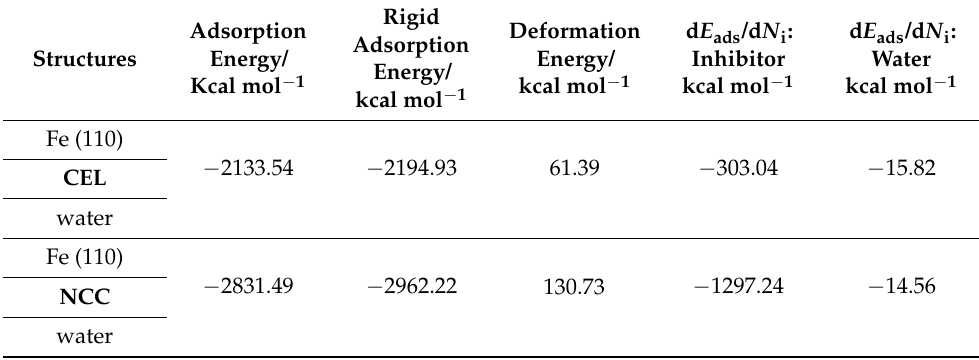
Table 5. Data and descriptors calculated by the Monte Carlo simulation (MC) for adsorption of the CEL and NCC on iron (1 1